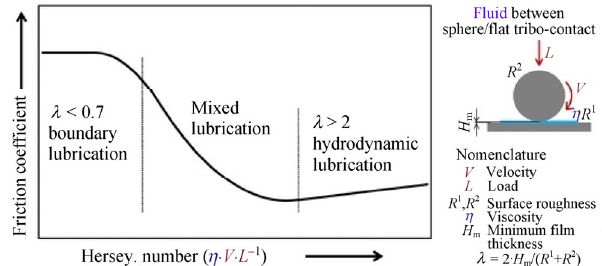
Fig. 1 Stribeck curve and lubrication regime [9]. H m (minimum thickness of liquid film developed from the base fluid between the surfaces, clearance of the surfaces) could be calculated from the operating parameters (load and velocity) and material parameters (elastic modulus and pressure–viscosity